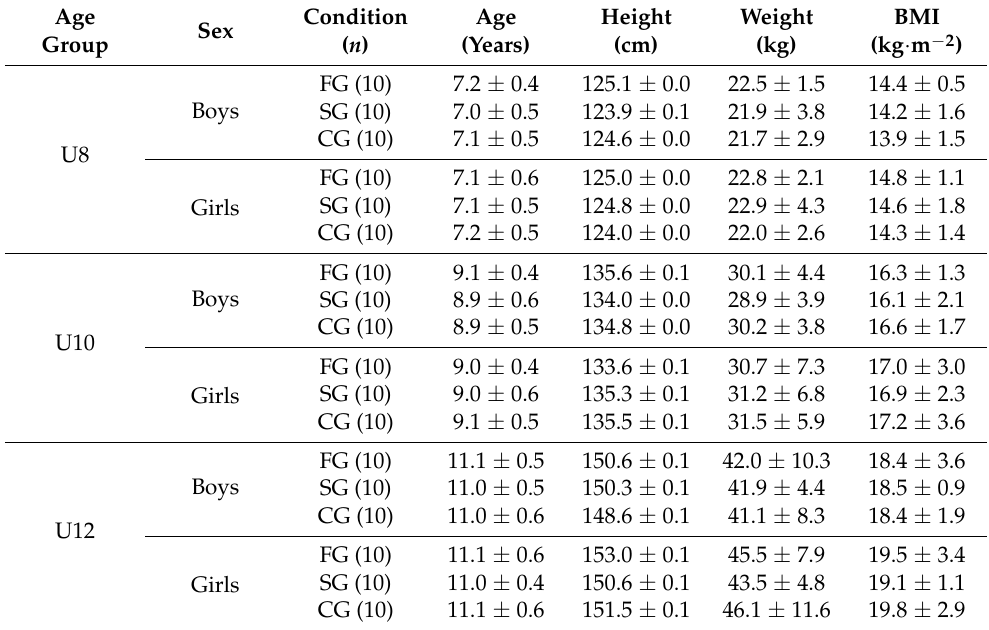
Table 1. Descriptive data of anthropometric and demographic parameters for the surface-type plyometric training and control groups at pre-test ( n =